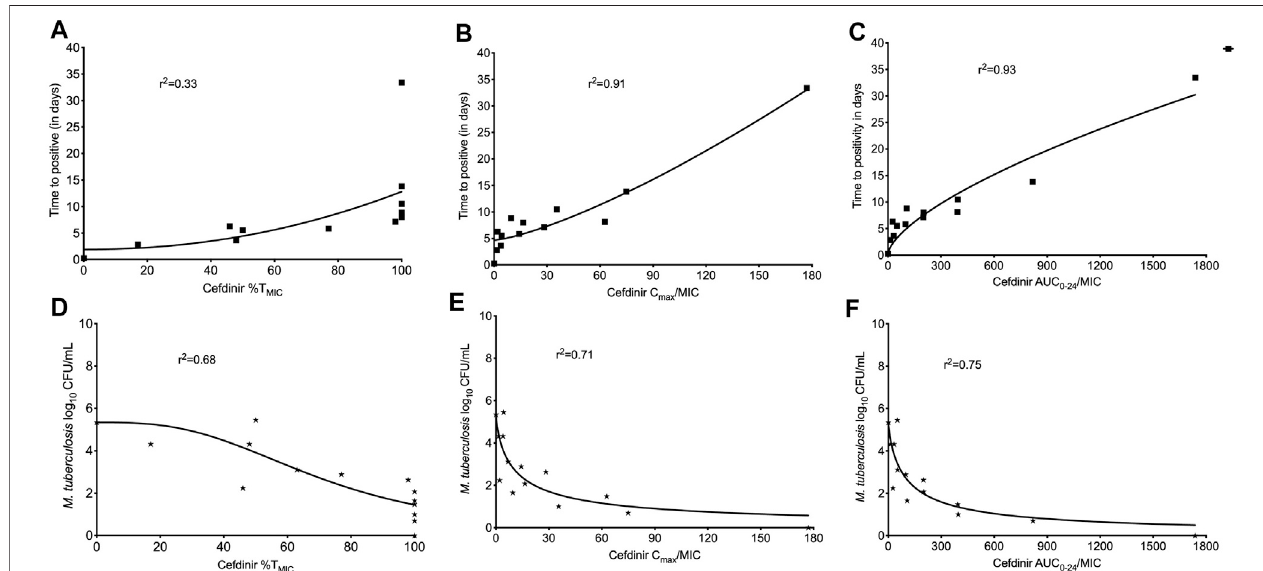
FIGURE5| Cefdinirsterilizingactivity againstmulti-drugresistanttuberculosis.Thecefdinirdoseswereselectedtomimic different%TMIC.However,the resultsof TTP,asasurrogateofbacterialburden,wereplottedagainstthe (A) %T MIC , (B) C max /MIC,and (C) AUC 0 – 24 /MIC.Onday28,theratioofAUC 0 – 24 /MICbestdescribedthe cefdinir Mtb kill. Similarly, the relationship between the bacterial burden aslog 10 CFU/ml and (D) %T MIC , (E) C max /MIC, and (F) AUC 0 – 24 /MIC on study day 28. Based on the lowest AIC score, AUC 0 – 24 /MIC was selected as the PK/PD index for cefdinir ef fi cacy against Mtb